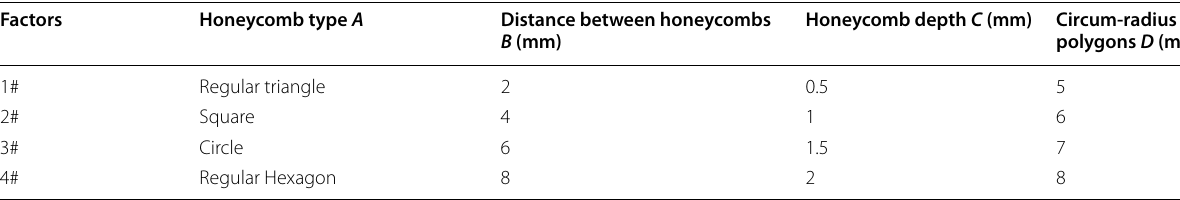
Table 1 Factors and levels Factors Honeycomb type